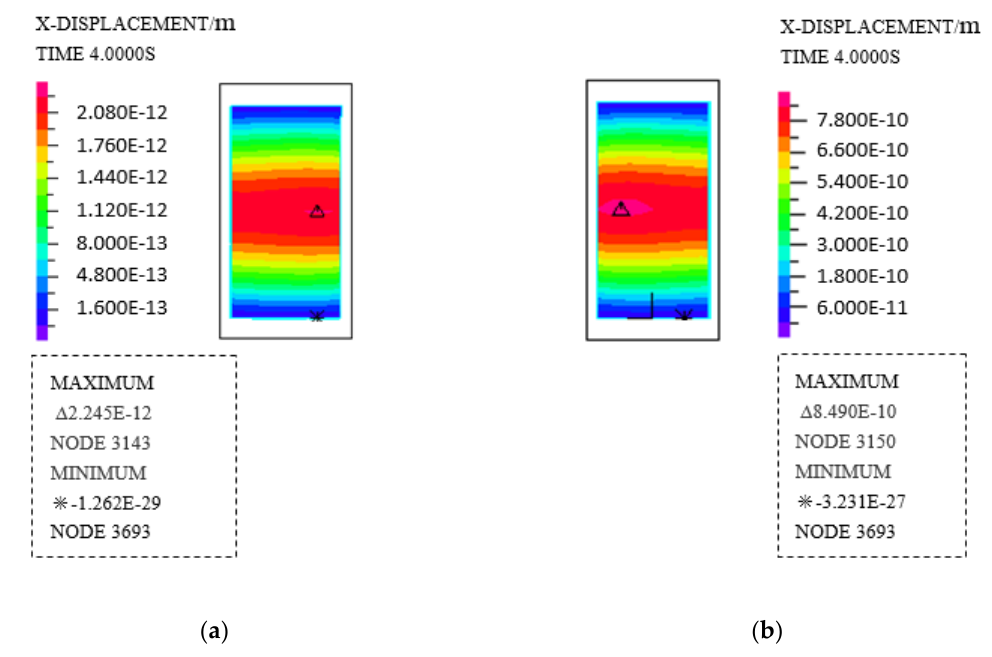
Figure 17. X-direction displacement cross-cutting nephogram ( a ) Rock sample models of laminar flow; ( b ) Rock sample models of Turbulence.